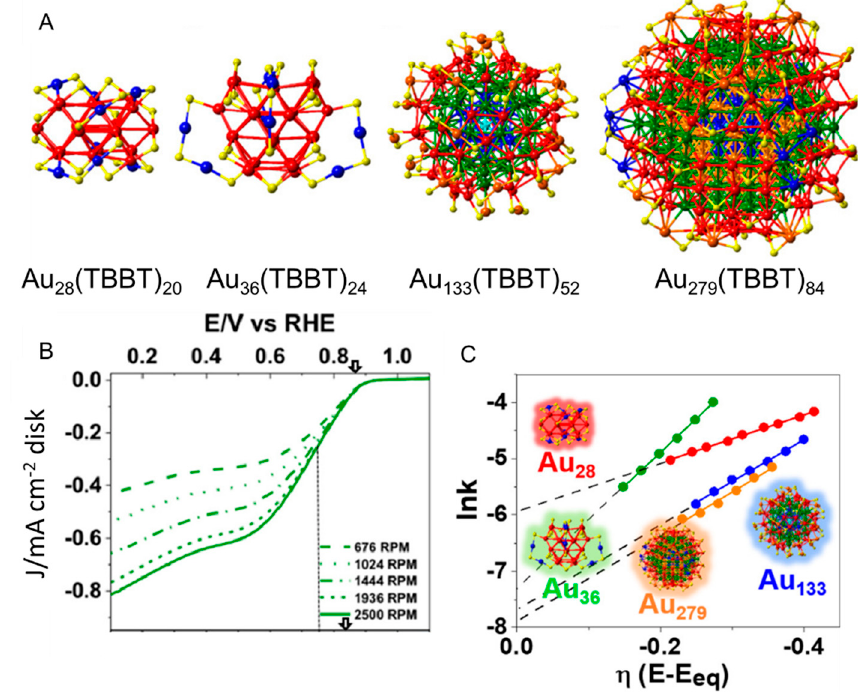
Figure 8. ( A ) X-ray crystal structures of Au n (TBBT) m NCs ( n = 28, 36, 133, and 279). ( B ) Rotating-disk voltammograms recorded for the ORR activity of Au 36 (TBBT) 24 / GCE at di ff erent rotation rates. ( C ) Reaction rate constant ln( k ) vs. overpotential E plots with each size of Au n (TBBT) m ( n = 28, 36, 133, and 279). Panels ( A – C ) are reproduced with permission from reference [113]. Copyright American